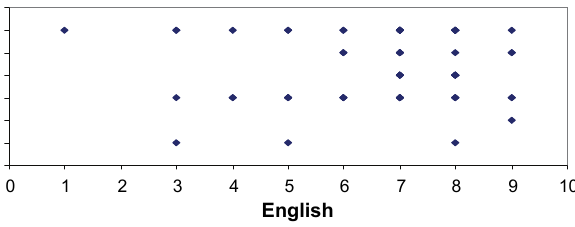
Figure 2: Scatter plot of Mathematics and English